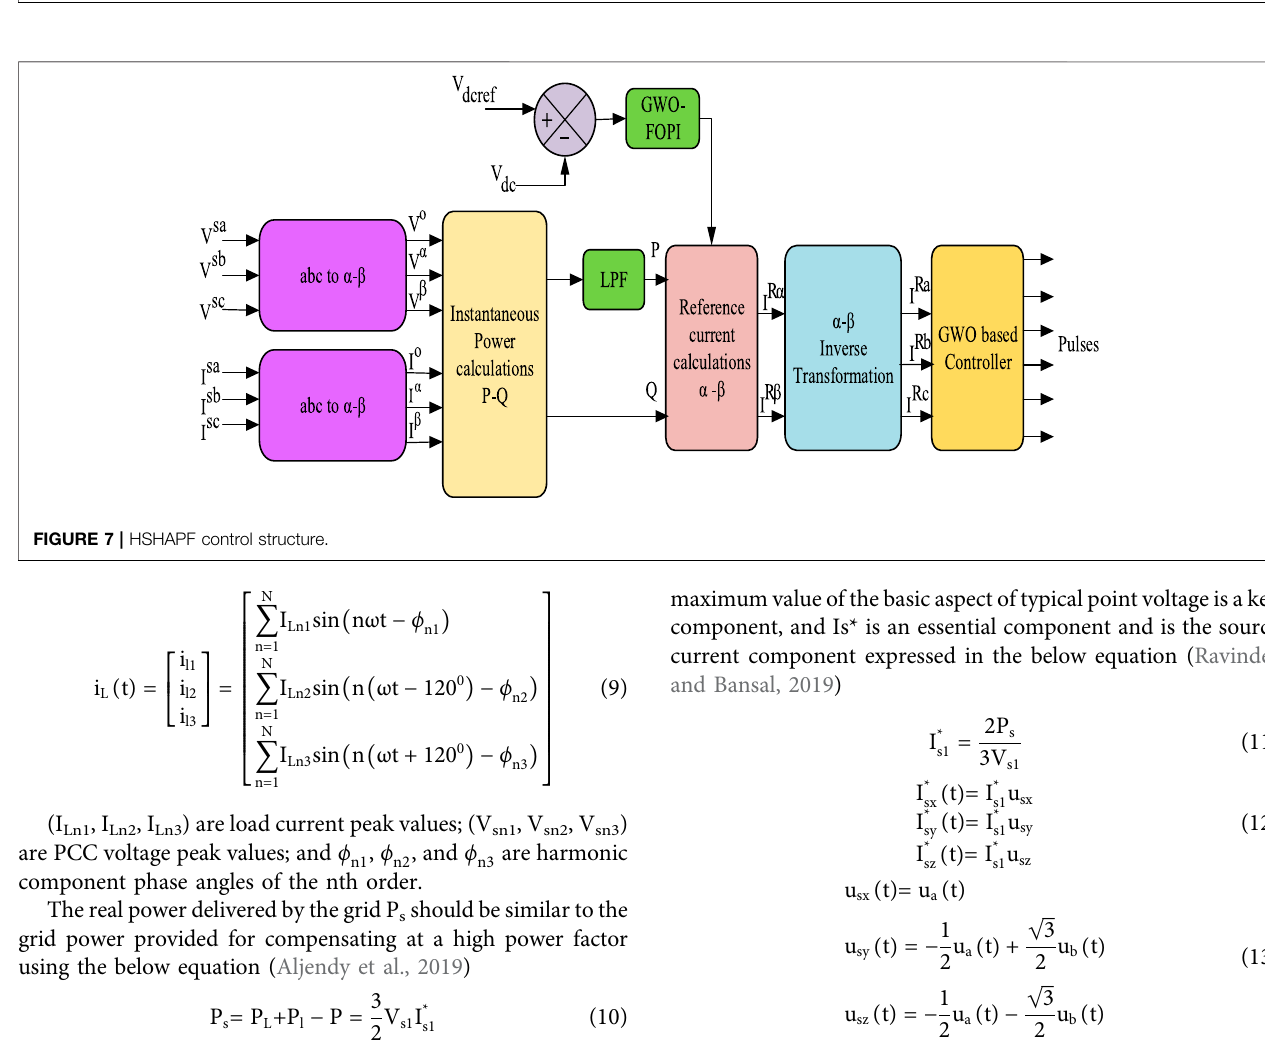
FIGURE 6 | Control structure of the proposed system.